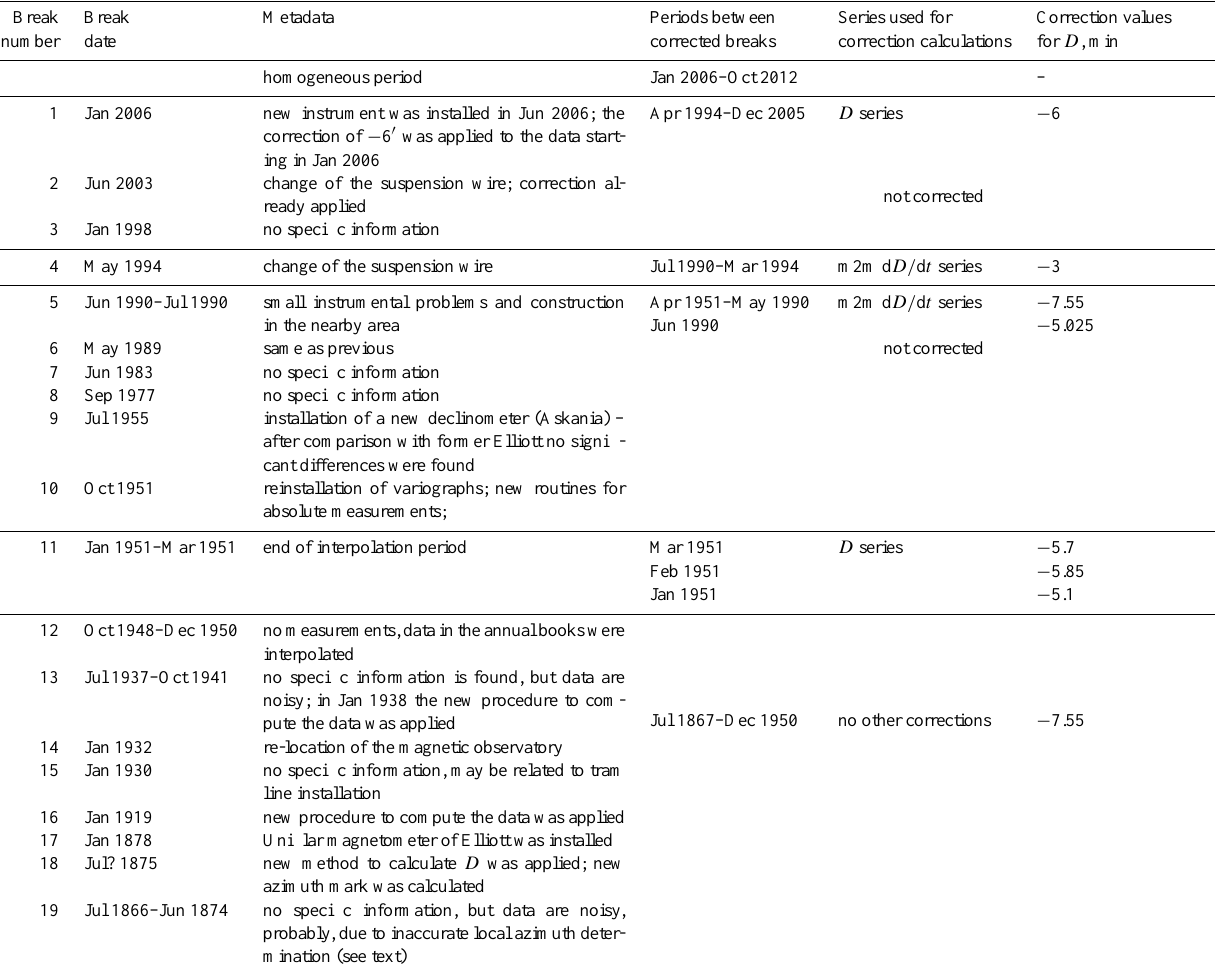
Table 3. A list of possible homogeneity breaks in COI D series for the period 1867 to 2012 found using metadata, visual analysis and statistical homogeneity tests. Only breaks after January 1951 were corrected. Correction values and correction methods for the periods between breaks are indicated in columns 5 and